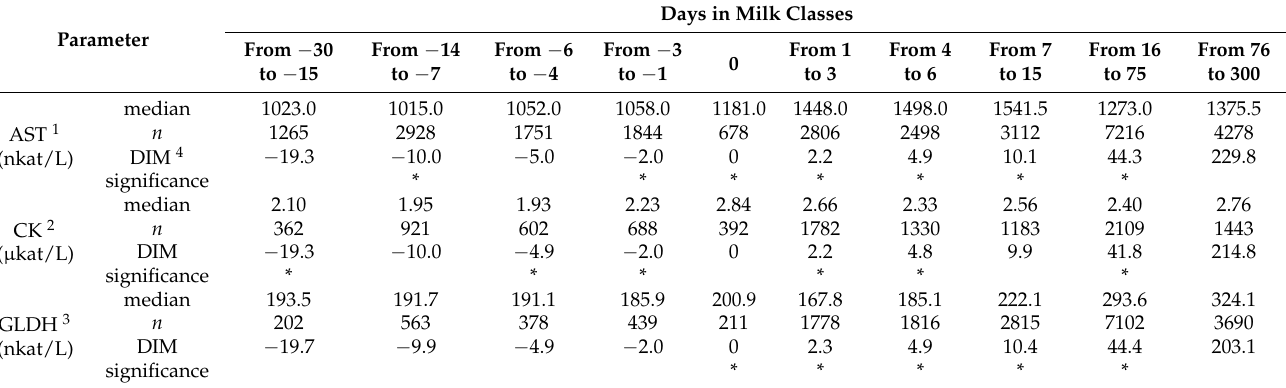
Table A4. Serum enzyme activities in ten DIM classes in multiparous cows.